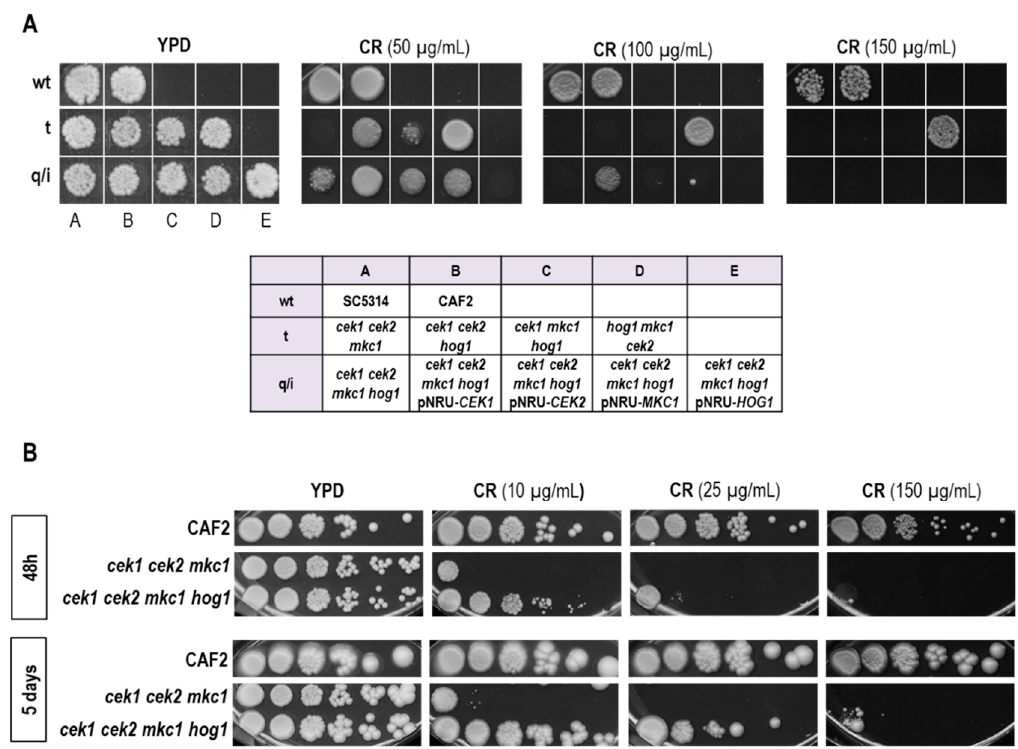
Figure 4. Comparative growth of MAPK mutants in the presence of Congo red. ( A ) Cells from a set of MAPK mutants from overnight grown cultures were spotted on solid agar plates of YPD medium supplemented or not (YPD-control) with di ff erent Congo red concentrations. Plates were incubated for 48 h at 37 ◦ C. ( B ) 10 5 cells and tenfold dilutions from overnight grown cultures were spotted on solid agar plates of YPD medium supplemented or not (control) with increasing concentrations of Congo red. Plates were incubated at 37 ◦ C for 48 h or five days. wt: wild type; t: triple mutants; q: quadruple mutant; i: quadruple mutants with an ectopically integrated